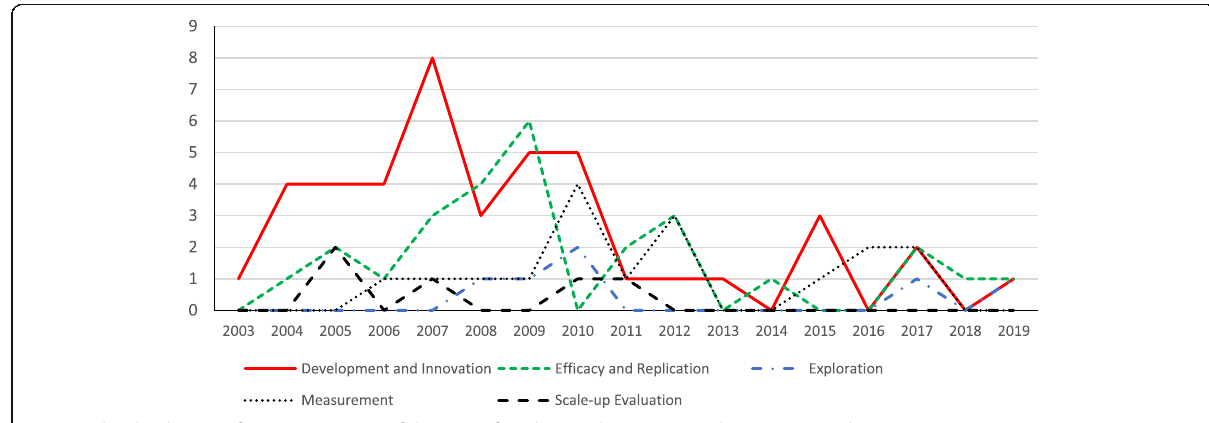
Fig. 16 The distribution of projects in terms of the type of goals over the years (in “ Education Research ” program)